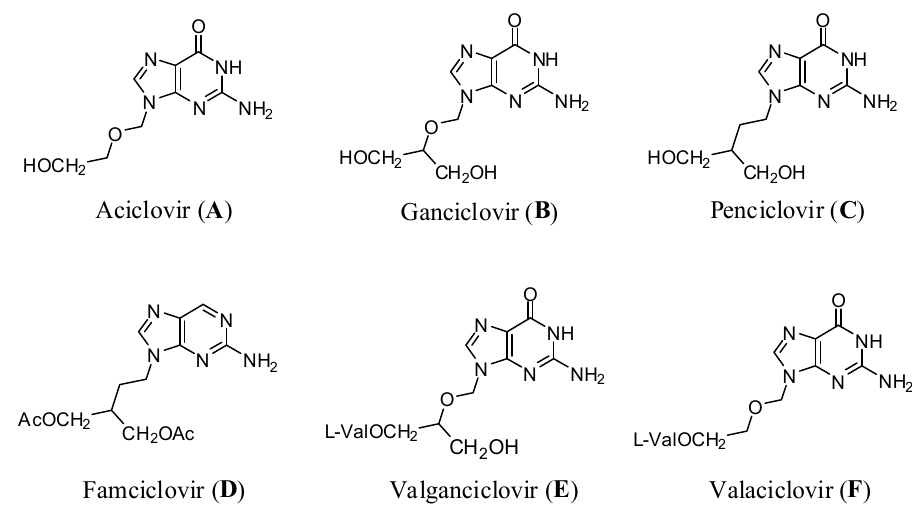
Figure 1. Known acyclonucleosides.